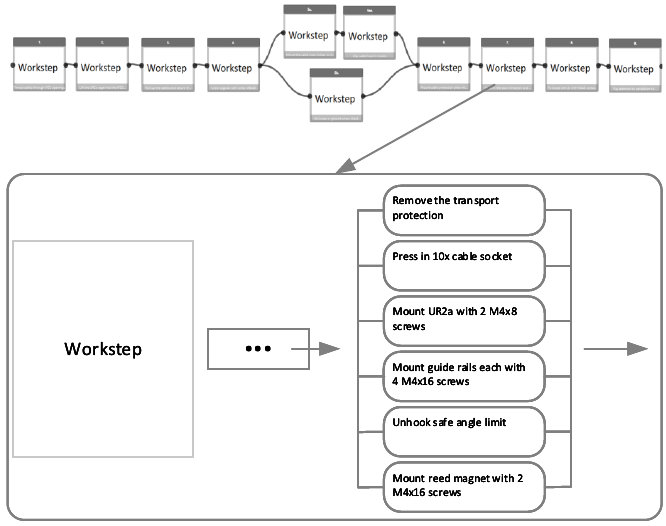
Figure 1. Macro to micro screwing